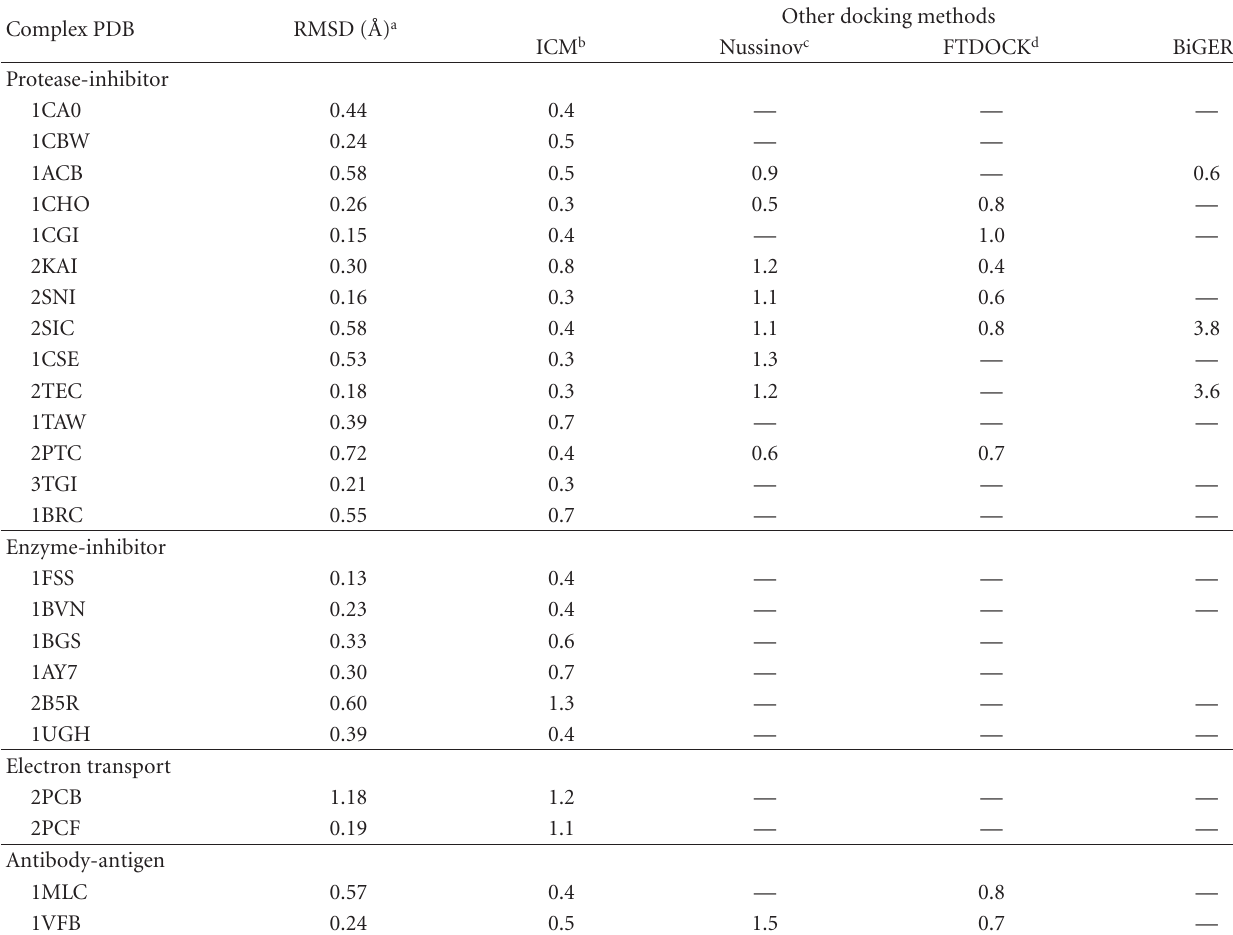
Table 2: Redocking results compared with other groups.